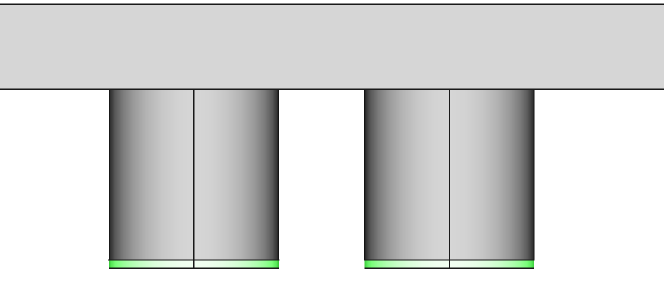
Figure 4. Close-up of the sensor model used for the FEM simulation. Sensor electrodes marked with green